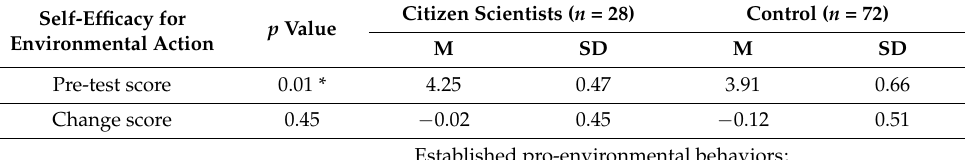
Table 6. Joint display of self-efficacy for environmental action mean (M) pre-test and change scores, standard deviations (SD), Mann–Whitney U p -scores (* significant at p < 0.05) and qualitative